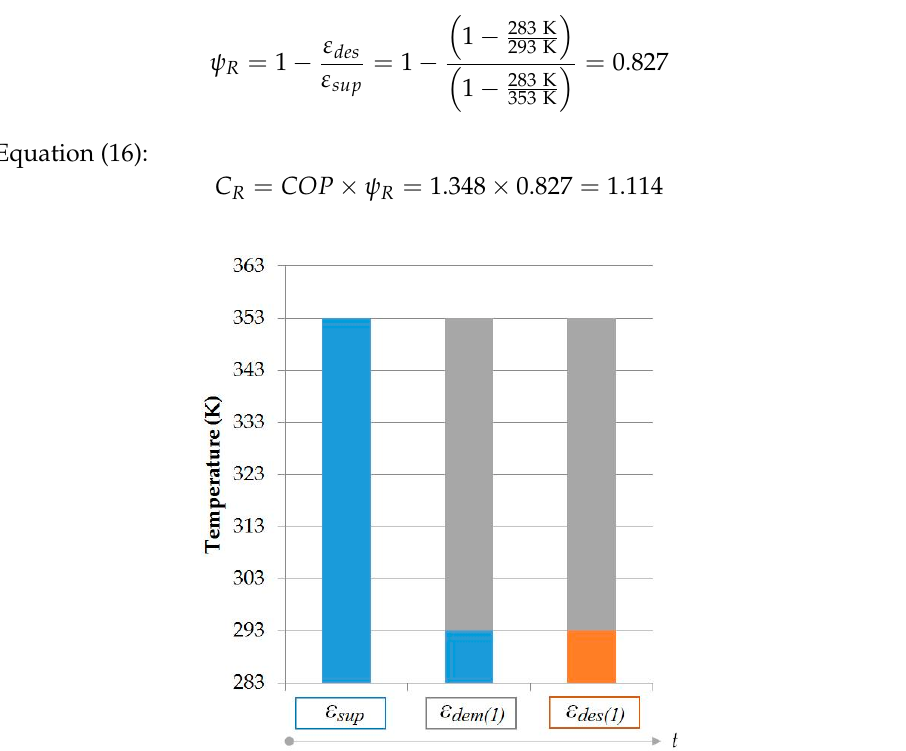
Figure 19. Exergy Flow Bars for the Circular Geothermal Option.